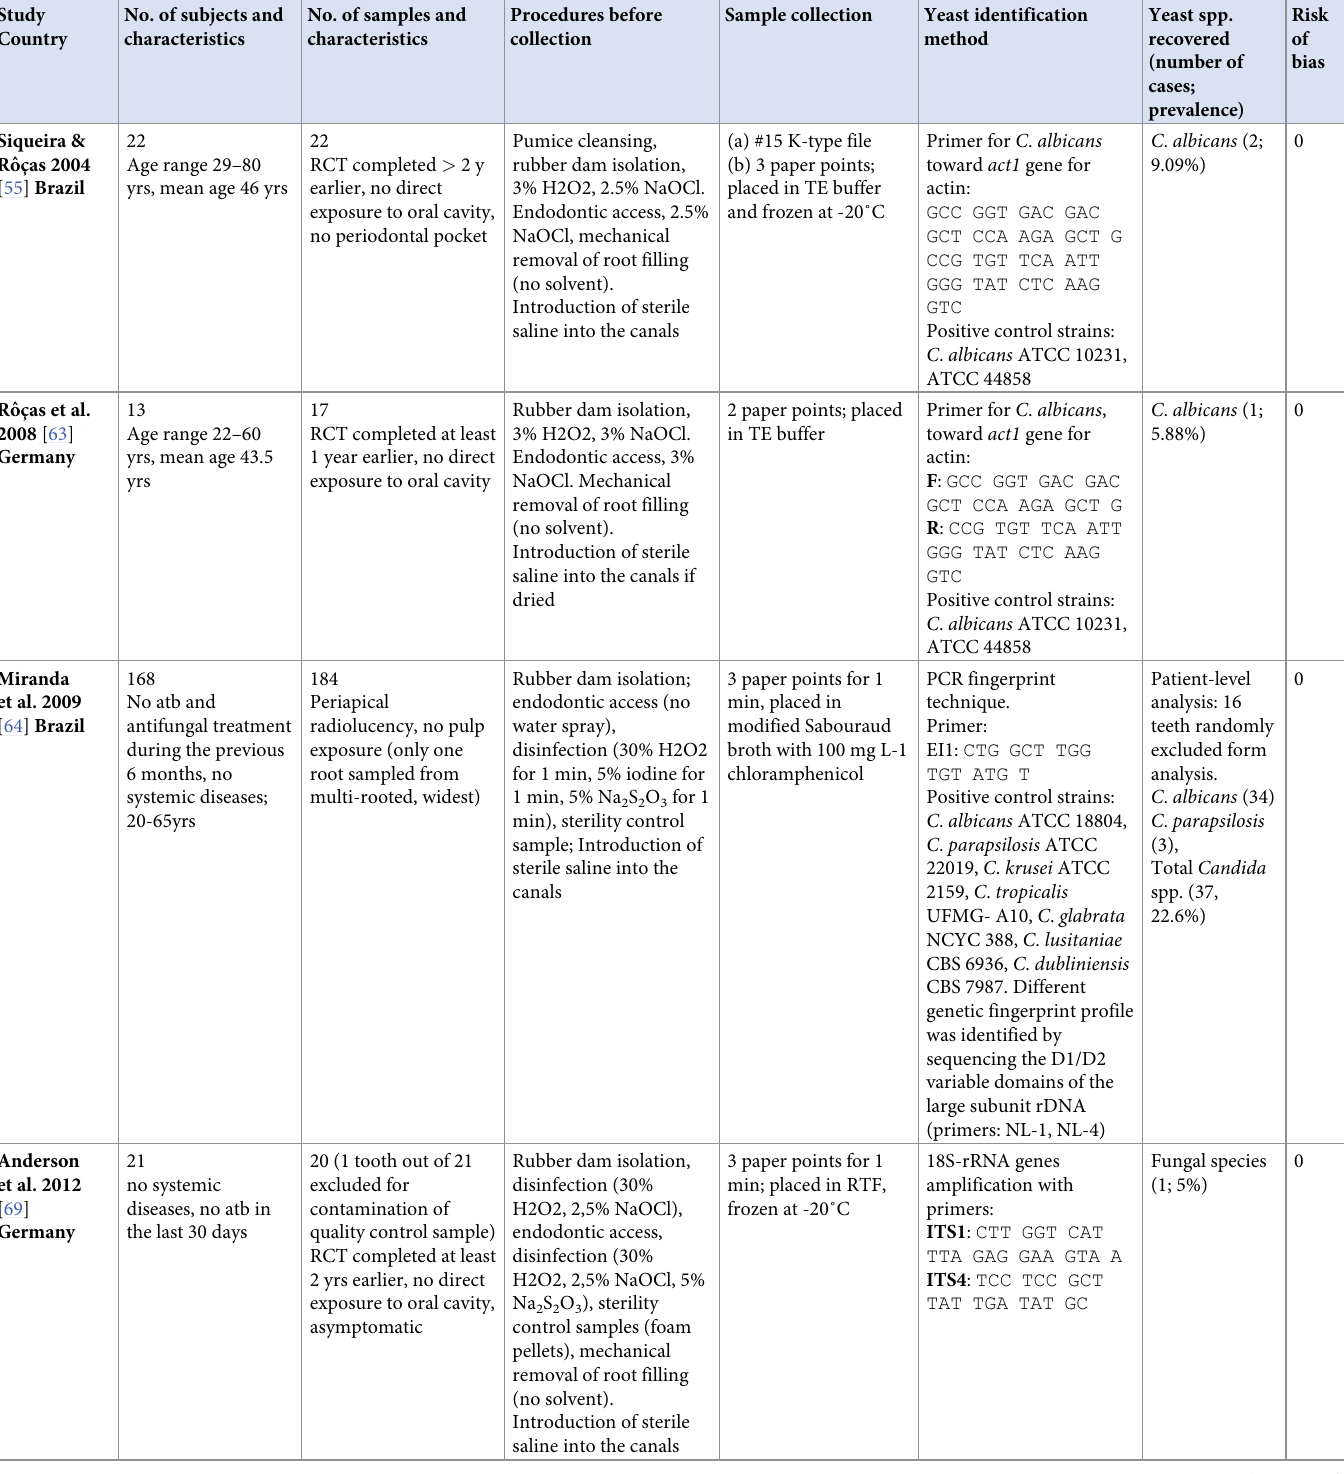
Table 5. Characteristics of the included studies using molecular methods for evaluating fungal presence in teeth with secondary endodontic infection. Study